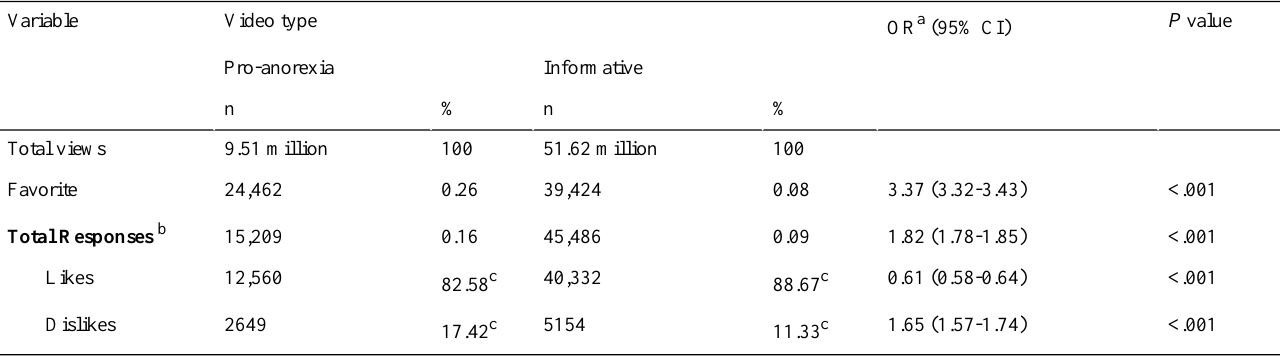
Table 2. Assessment of the 20 most-viewed anorexia-related videos on